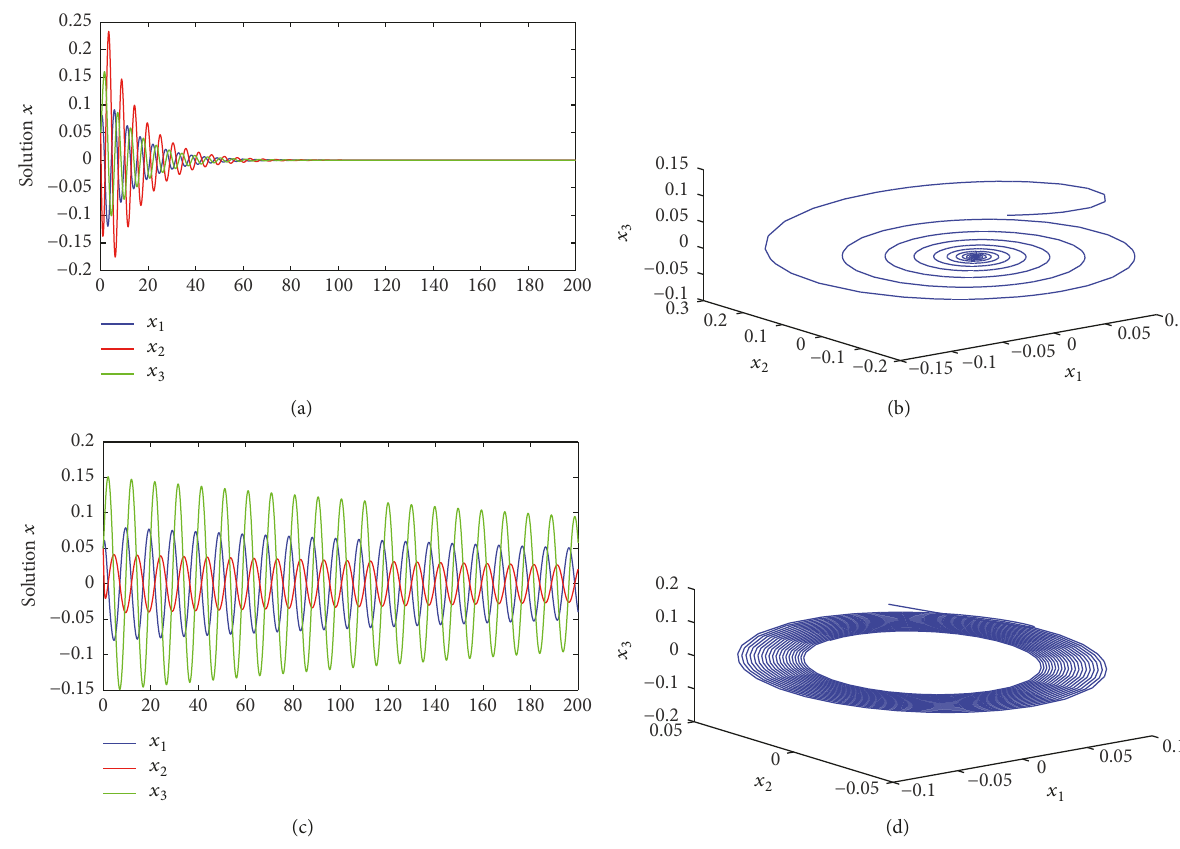
Figure 5: The corresponding oscillation curves and phase portrait of the PI hydroturbine governing system. (a) The corresponding oscillation curves for 𝐾 𝑃 = 5 and 𝜏 2 ∈ [0, 𝜏 20 ) . (b) The phase portrait with 𝐾 𝑃 = 5 and 𝜏 2 = 0.35 s ∈ [0, 𝜏 20 ) . (c) The corresponding oscillation curves with 𝐾 𝑃 = 1.5 and 𝜏 2 ≥ 𝜏 20 . (d) The phase portrait with 𝐾 𝑃 = 1.5 and 𝜏 2 = 0.46 s ≥ 𝜏 20